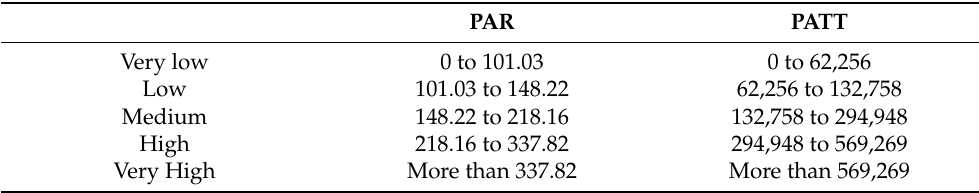
Table 14. Assessment table of the PATT and PAR points at the UPC, year 2003 and following. PAR PATT Very low 0 to 101.03 0 to 62,256 Low 101.03 to 148.22 62,256 to 132,758 Medium 148.22 to 218.16 132,758 to 294,948 High 218.16 to 337.82 294,948 to 569,269 Very High More than 337.82 More than